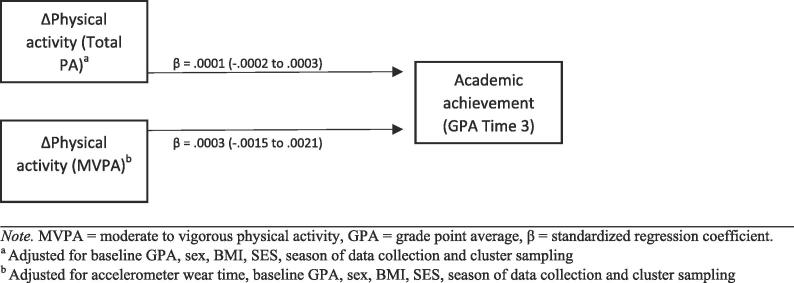
Parameter estimates of the regression coefficient (95% CI) of the prospective associations between changes (2016–2018) in physical activity (Total PA and MVPA) and academic achievement Time 3. (n = 401).